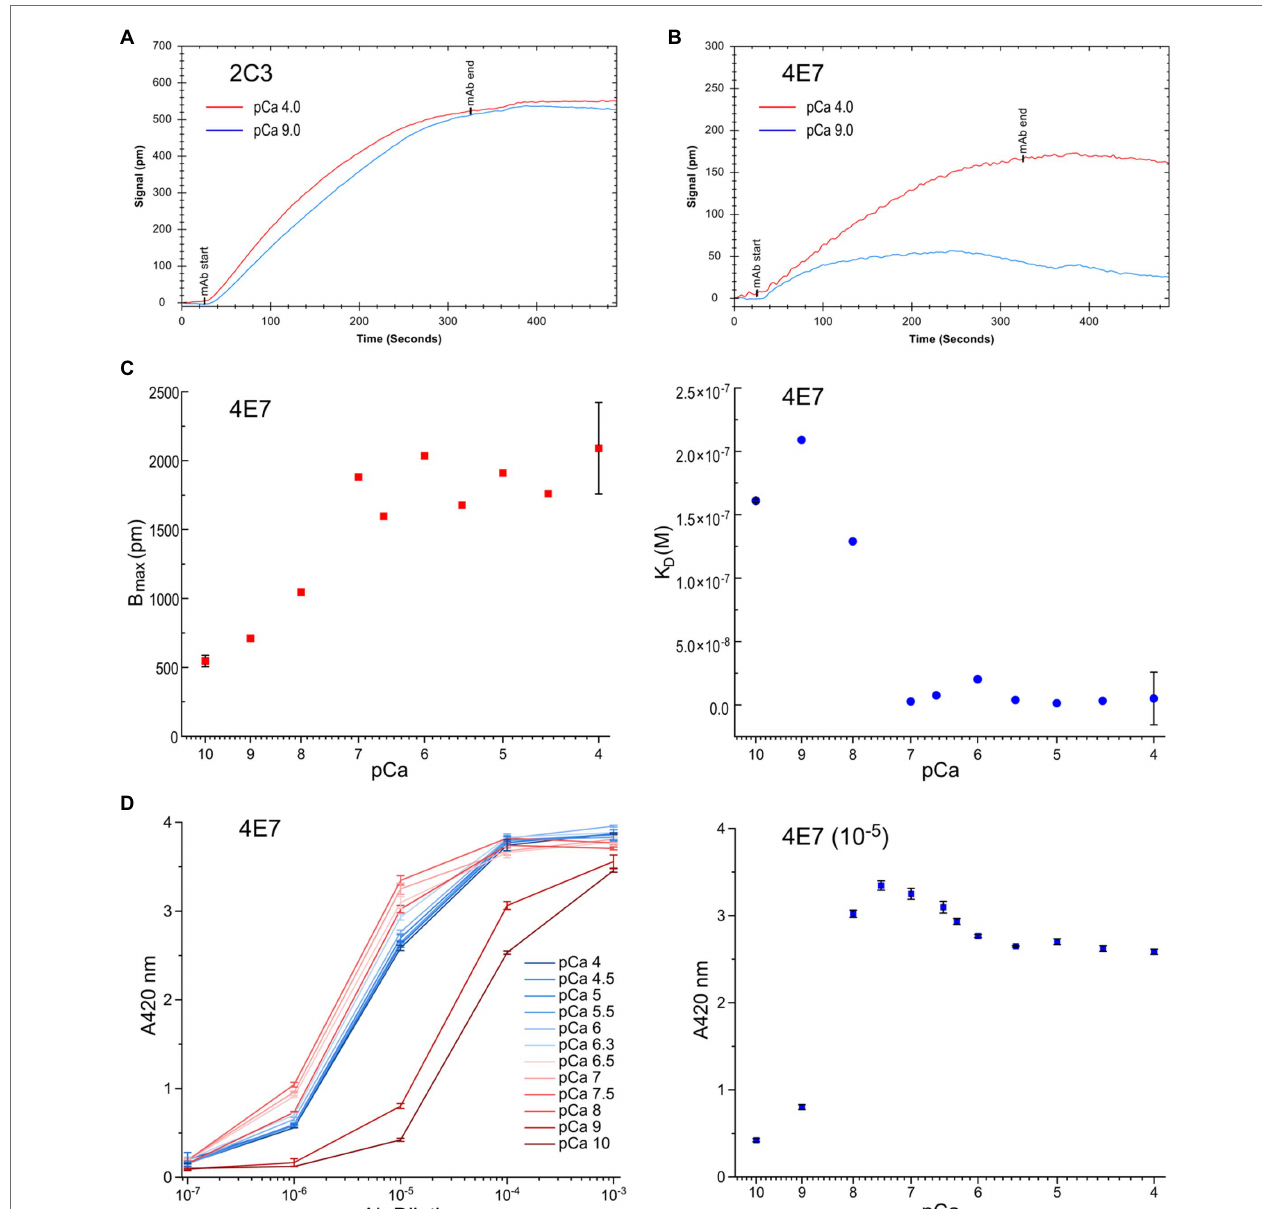
FIGURE 6 | Conformational effect of Ca 2+ binding to fast TnC detected in quantitative LSPR assay. (A) Changes in buffer pCa did not affect the binding of mAb 2C3, consistent with the observation in ELISA that mAb 2C3 binding to fast TnC remains constant regardless of ion binding. In addition, the binding signal of mAb 2C3 confirms constant protein coating on the LSPR chip. (B) In contrast, the binding of mAb 4E7 against the N domain of fast TnC changes with the change in pCa. A significant decrease in association rate and increase in dissociation rate at pCa 9.0 vs. pCa 4.0 are detected, indicating weaker binding of the mAb probe in the Ca 2+ -free state. (C) The physiological range pCa titration curve of mAb 4E7 binding with LSPR indicates that fast TnC changes conformation when [Ca 2+ ] increases. The maximum binding of mAb 4E7 to the fast TnC chip, B max , increased in a gradual manner to a plateau level when [Ca 2+ ] reached pCa 7.0, while K D , the equilibrium dissociation constant, started to decrease when [Ca 2+ ] increases to pCa 8.0 and rapidly minimized at pCa 7.0. (D) The ELISA titration curves of mAb 4E7 binding to fast TnC at the same range of pCa (left panel) show a dramatic increase in affinity from pCa 10.0 to pCa 8.0. At sub-saturated concentration of mAb 4E7 (10 − 5 dilution, right panel), the [Ca 2+ ] titration curve reveals three-phases of binding affinity changes: A rapid increase from pCa 10 to 7.5, a small decrease from pCa 7.5 to 5.5, and a plateau above pCa